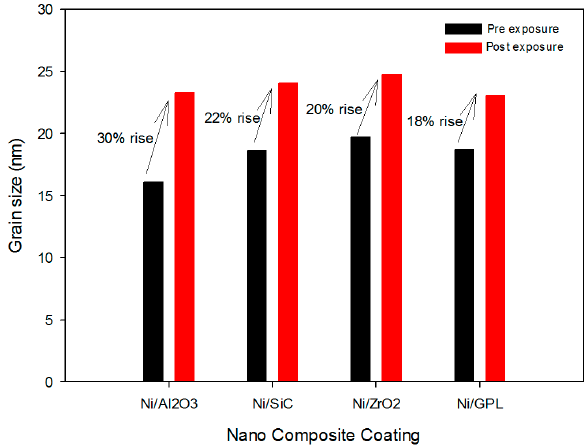
Figure 3. Grain size as a function of different nano composite coatings.